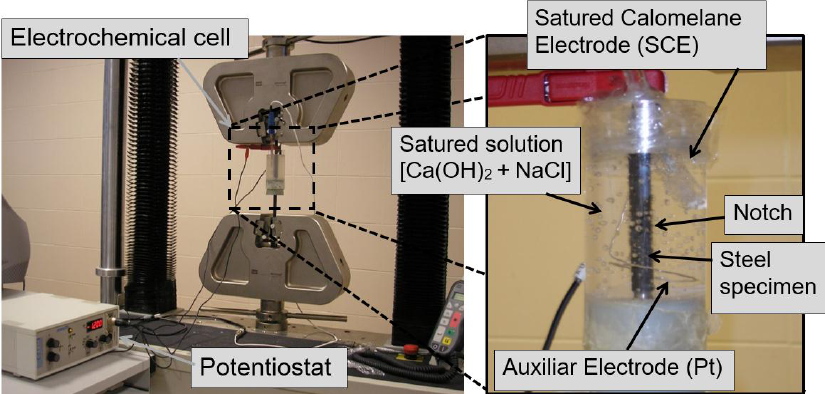
Figure 3. Constant extension rate tensile (CERT) test under cathodic electrochemical conditions including a detailed view of the electrochemical cell.